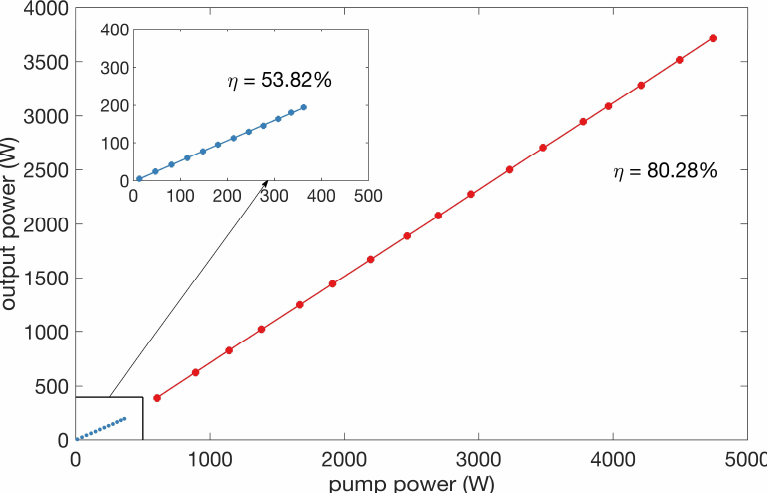
Figure 5. Output power versus pump power. The blue dots and blue line represent power scaling with forward pumping, and the red ones stands for those with backward pumping.